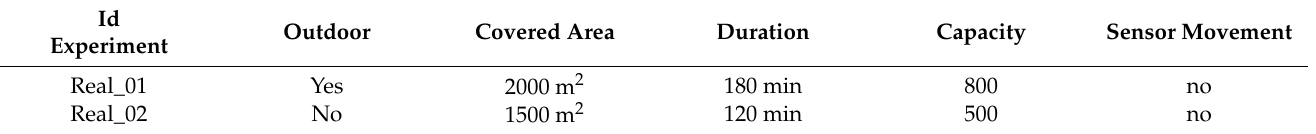
Table 4. Validation experiments’ results.